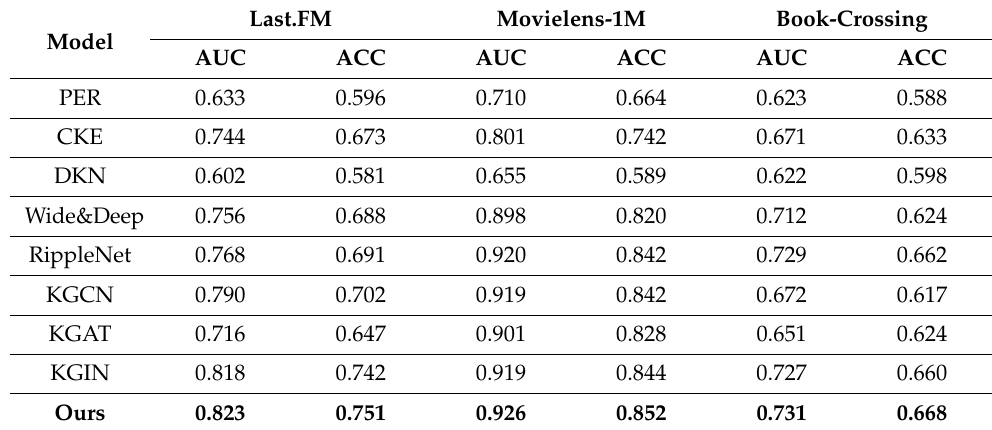
Table 2. Comparison